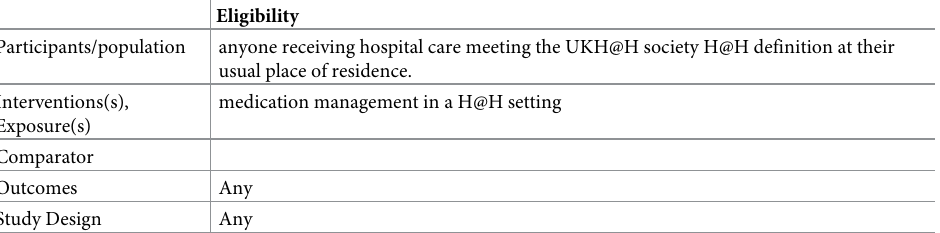
Table 1. Eligibility criteria for selecting